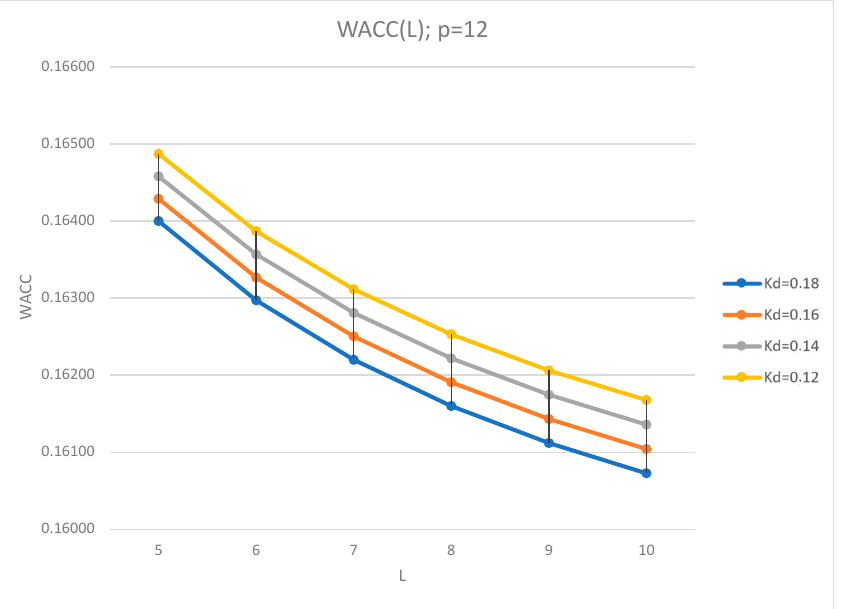
Figure 5. Dependence of the weighted average cost of capital (WACC) on leverage level L at different debt cost k d (12%; 14%; 16%; 18%) and fixed frequency of payments of tax on profit p = 12 (larger scale).